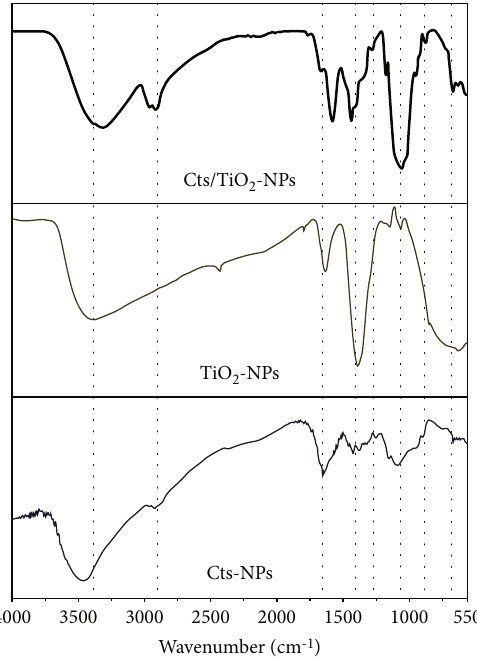
Figure 2: Infrared spectral analysis (FTIR) of chitosan nanoparticles (Cts-NPs), titanium dioxide nanoparticles (TiO NPs), and their composite (Cts/TiO